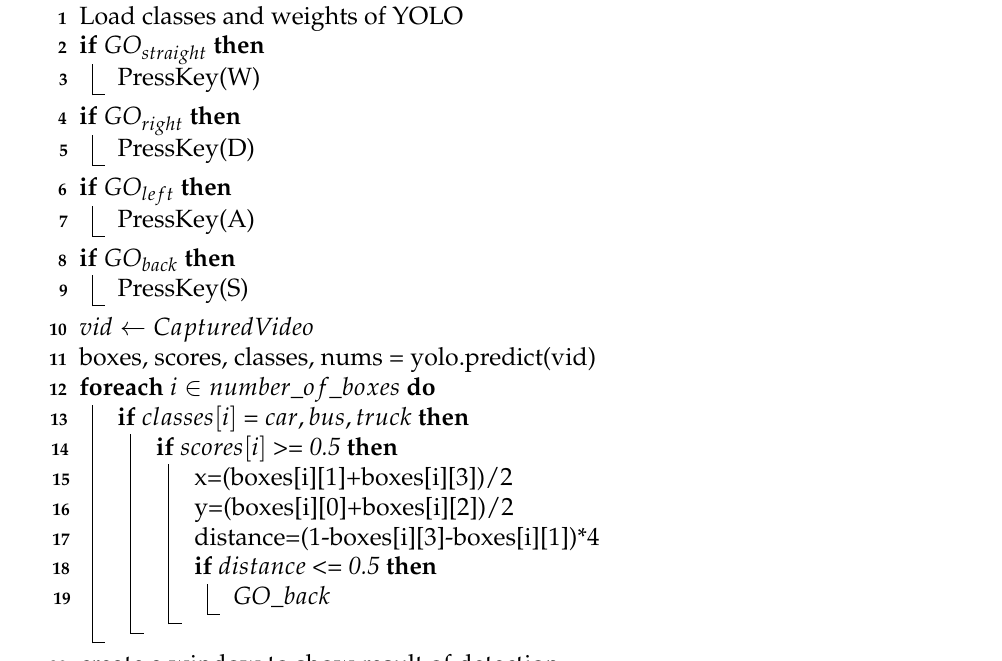
Algorithm 1: Pseudo code of object detection